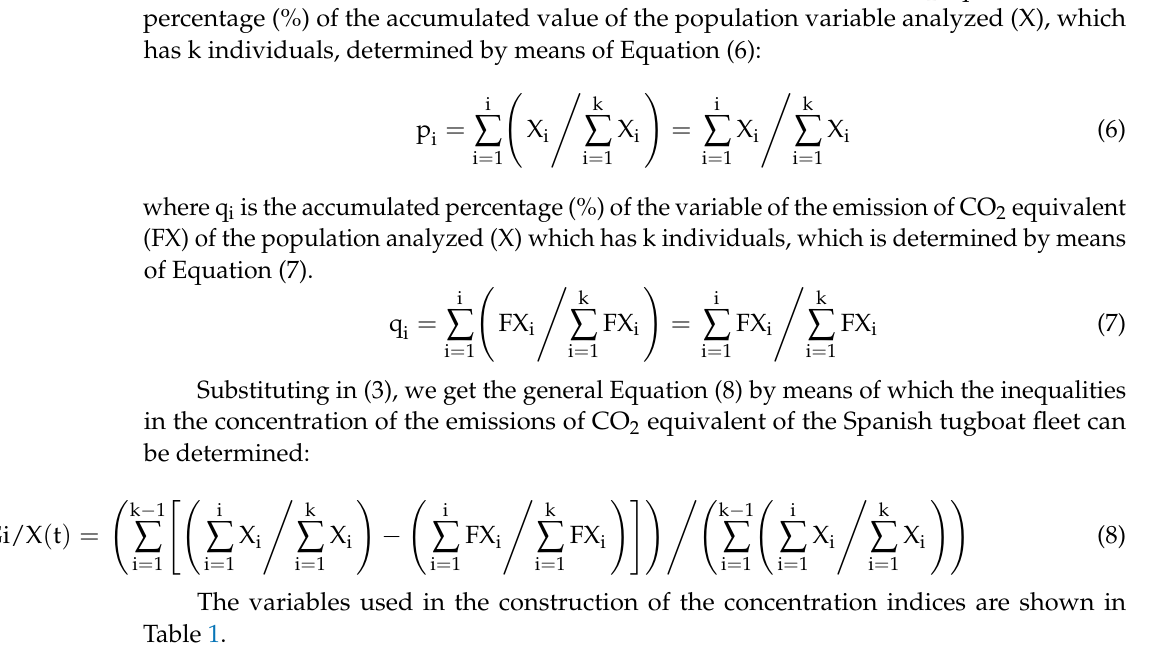
Table 1. Variables used in the construction of the concentration